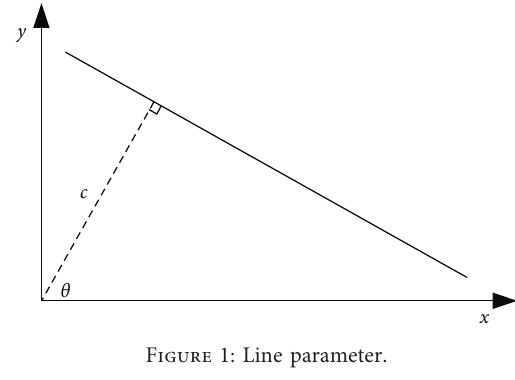
Figure 1: Line parameter.